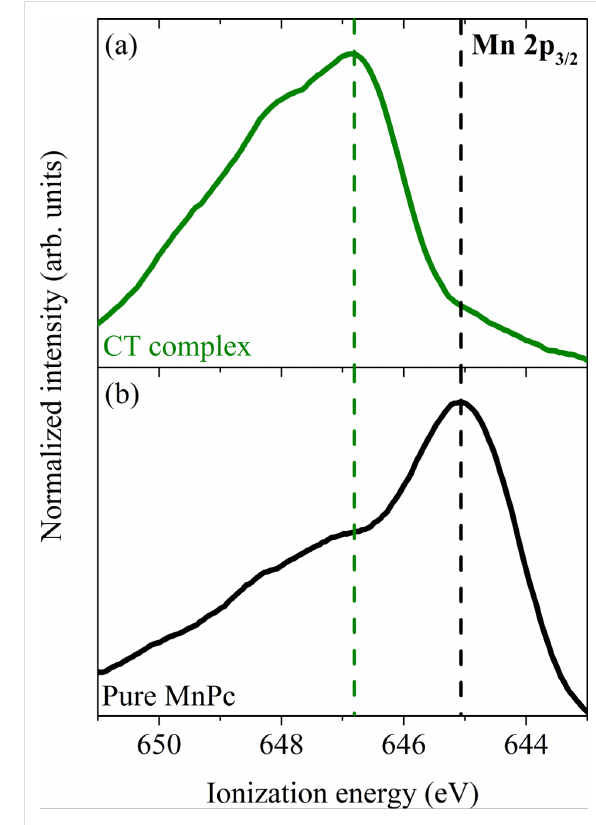
Figure 6: Core-level photoelectron spectroscopy data in the energy region of the Mn 2p 3 / 2 core level (adapted from [104]). Note that the energy is referenced to the vacuum level in this case, since two differ- ent compounds with different Fermi-level positions are compared. Panel (a) shows the core-level emission of the MnPc/F 4 TCNQ charge- transfer compound, while panel (b) shows that of pure MnPc.